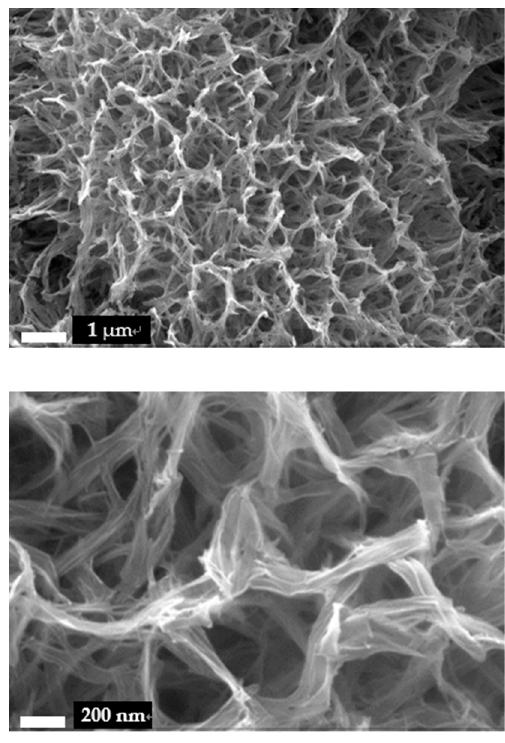
Figure 2. SEM images of the top view of HTNTs/Ti .